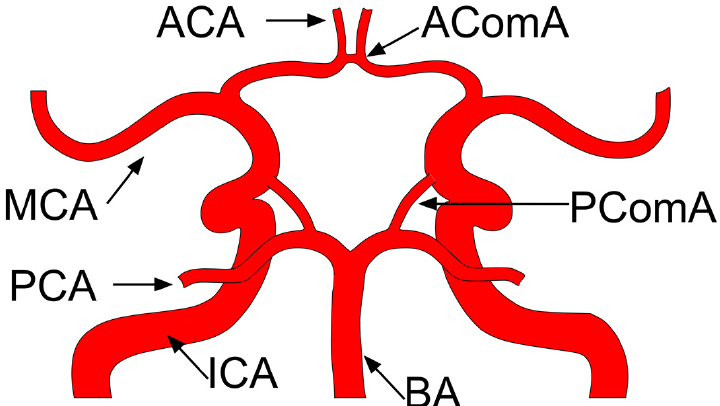
Figure 1. Schematic diagram of a classic circle of Willis. ACA anterior cerebral artery; MCA middle cerebral artery; PCA posterior cerebral artery; ICA internal carotid artery; BA basilar artery; AComA anterior communicating artery; PComA posterior communicating artery.